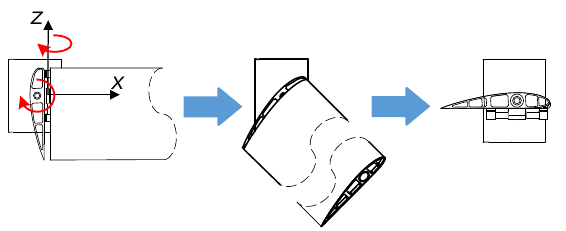
Figure 4. Folding wing deployment process (synchronous deployment).